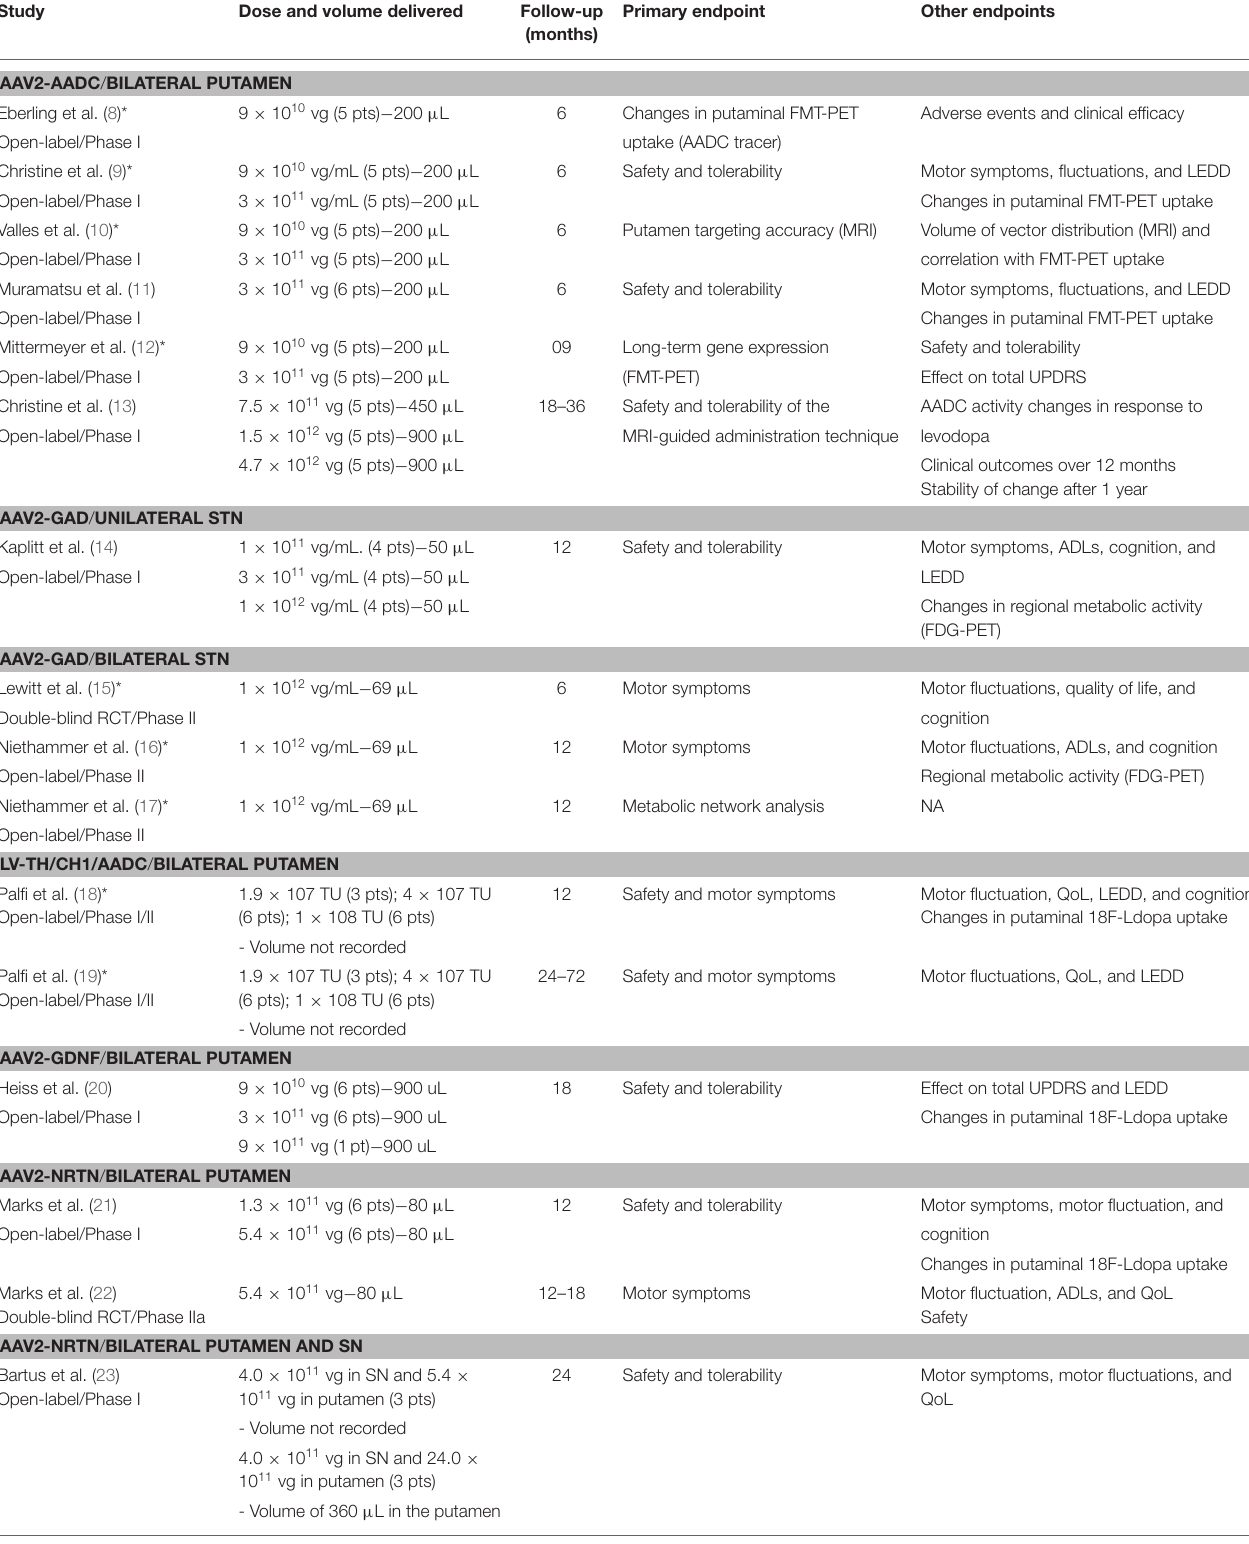
TABLE 3 | Reviewed articles—sample characteristics and endpoints—Parkinson disease. Study Dose and volume delivered Follow-up